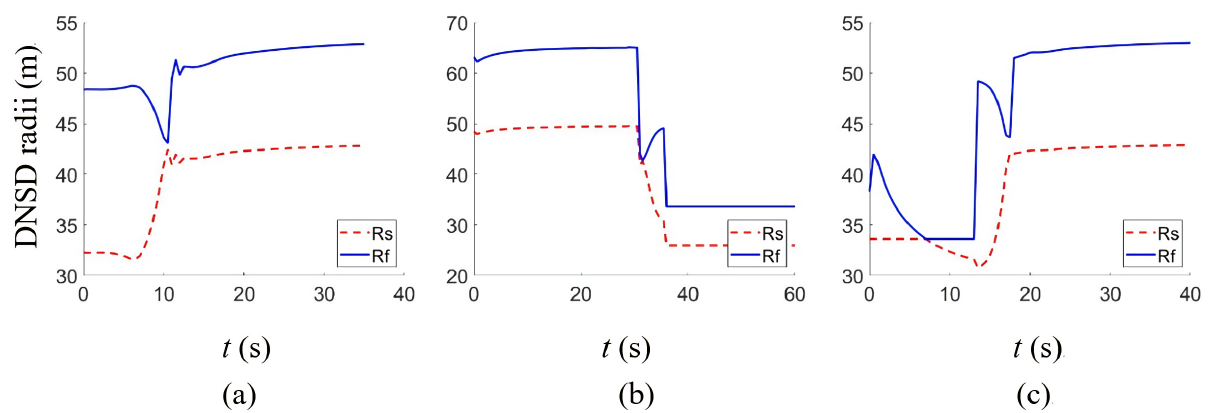
Figure 11. The changes of the ship domain dimensions for different encounter situations: ( a ) crossing; ( b ) overtaking; ( c ) head − on.